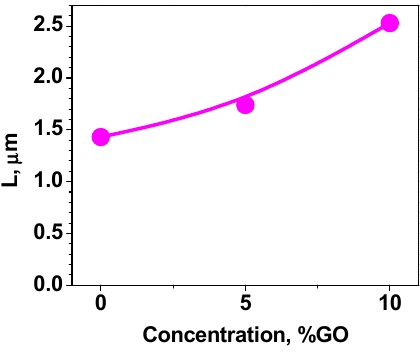
Figure 9. Concentration dependence length of domain after poling (U = − 75 V, t = 50 s).